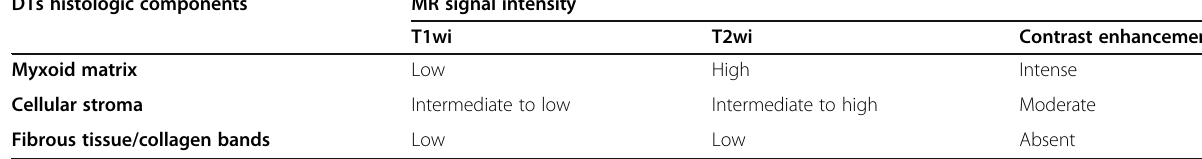
Table 2 Relationship between MR signal intensity and histologic components